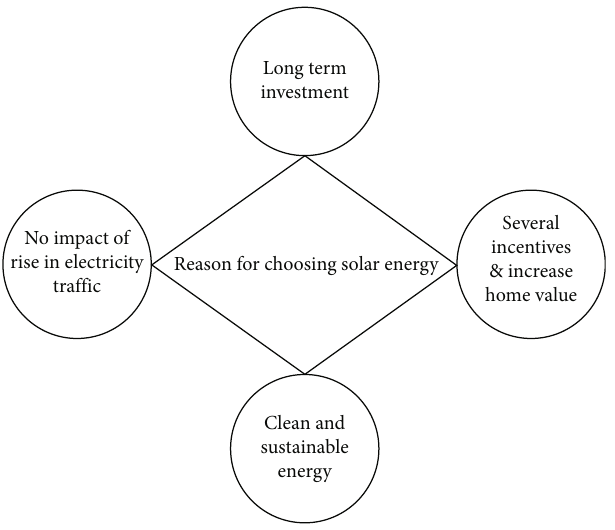
Figure 2: Various reason for selecting solar